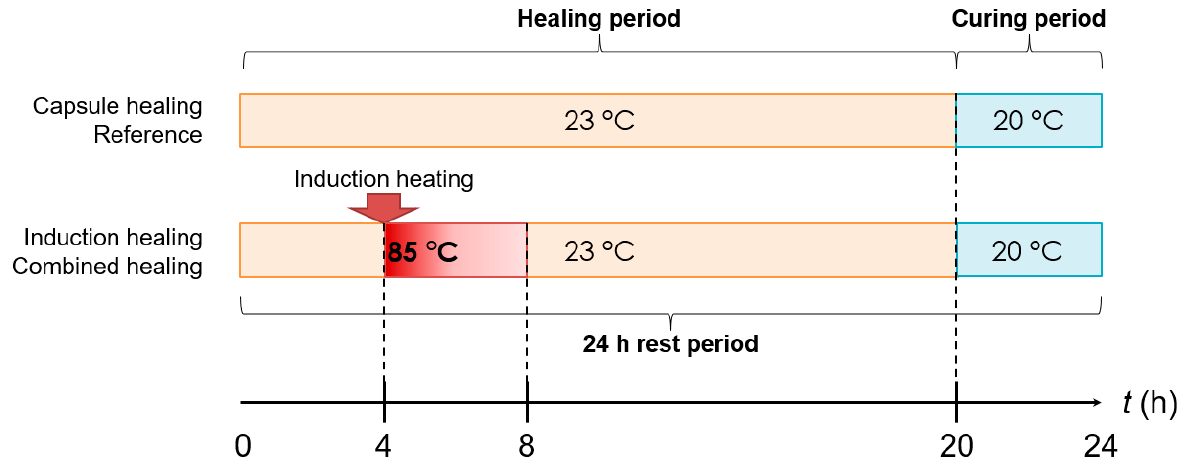
Figure 9. 24-h rest period for the healing of various healing systems.